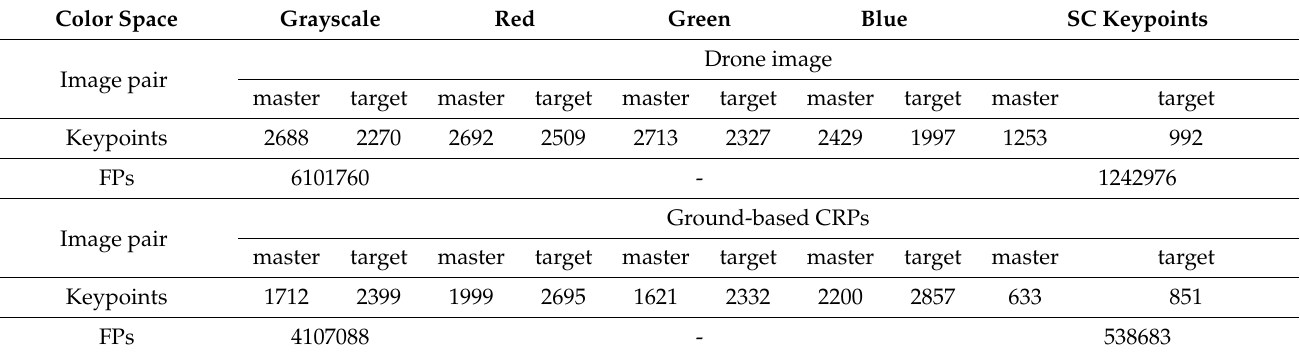
Table 3. Number of keypoints detected and feature pairs (FPs) of each benchmark image pair in the four color spaces for CRPs.